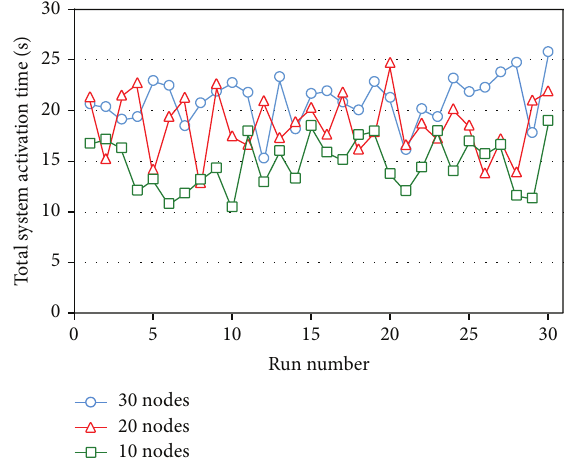
Figure 12: Line chart of the experiment result of transmitting 7 sessions in a 10-node network.